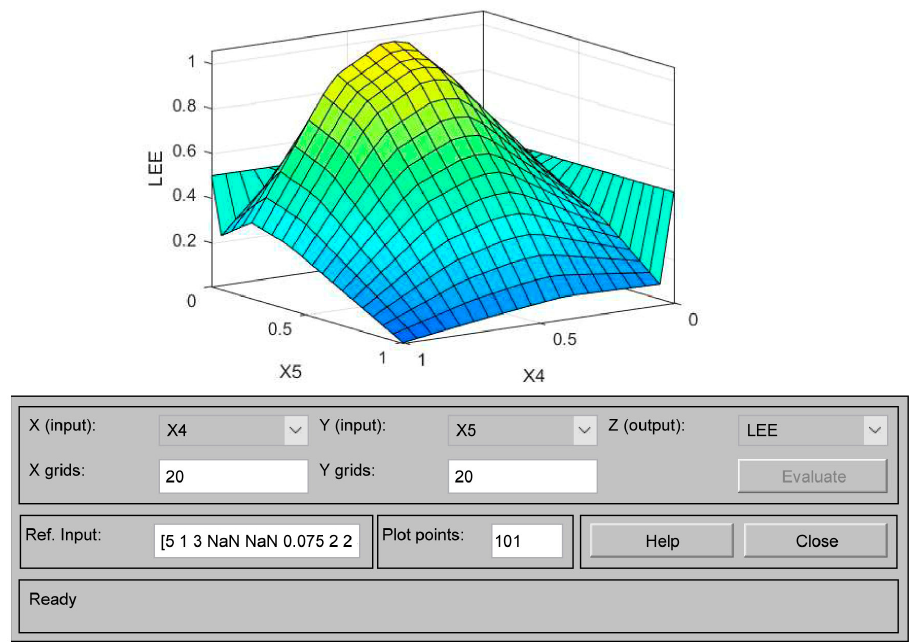
Figure 4. Dependence of LEE ( x 4 , x 5 ) on the degree of use of load capacity ( x 4 ) and traffic flow complexity level ( x 5 ).